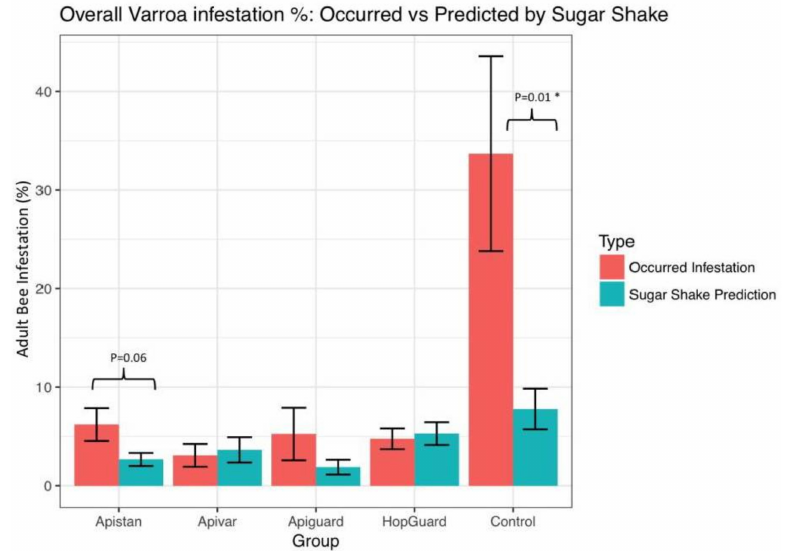
Figure 7. Percentage of adult bees infested by Varroa mites, detected by sugar shake test, during the pre-treatment period (July), after four treatment protocols (Apiguard ® , Apistan ® , Apivar ® , and HopGuard ® ) (August) and final treatment of CheckMite ® (September). Bars represent mean ± 1 SE. ANOVA significant levels are as follows: p < 0.05 *. The horizontal brackets indicate significant differences between the actual and predicted levels of Varroa mite